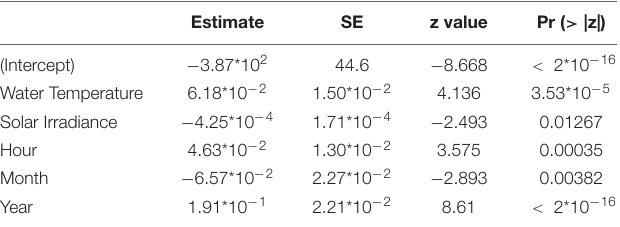
TABLE 3 | Results from the most representative GAM modeling for the grouping or not grouping behavioral data of D. dentex, where metrics are also indicated: SE is the Standard Error of the estimated fitted mean